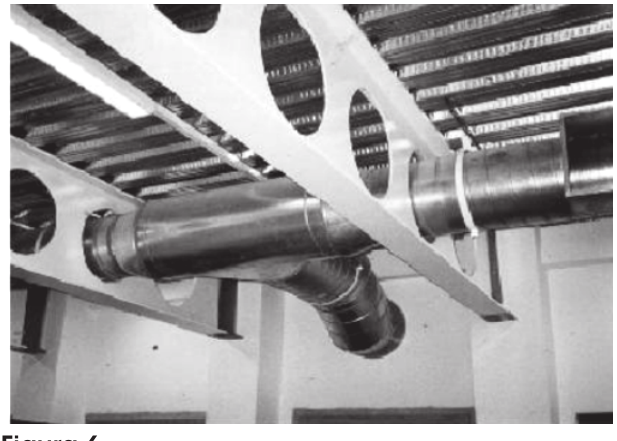
Figura 6 Aplicação de viga mista com perfil celular